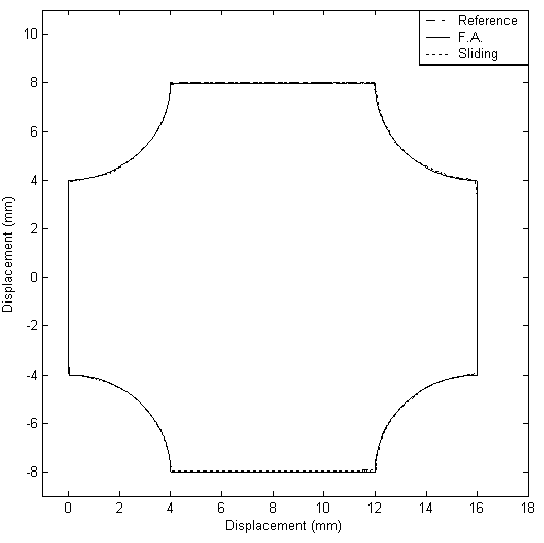
Figure 8. X-Y table displacement (case